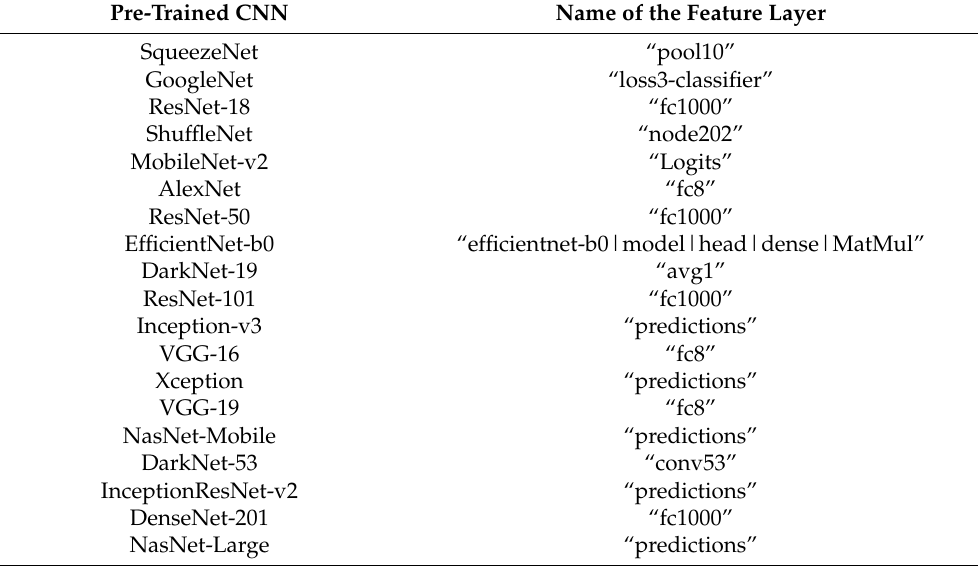
Table 2. Feature layer of different pre-trained CNNs.